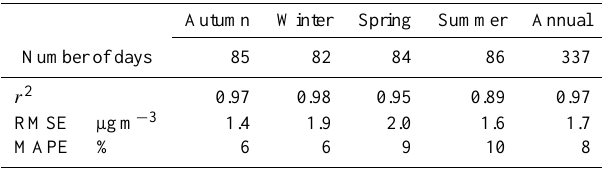
Table 2. Seasonal variability of statistics describing the ability of PMF to model PM 2 . 5 . RMSE: root mean square error, MAPE: mean absolute percentage error. Note that r 2 was determined by plotting the modelled (sum of the contributions of the sources) versus the measured PM 2 . 5 mass. Calendar seasons were used (see Table